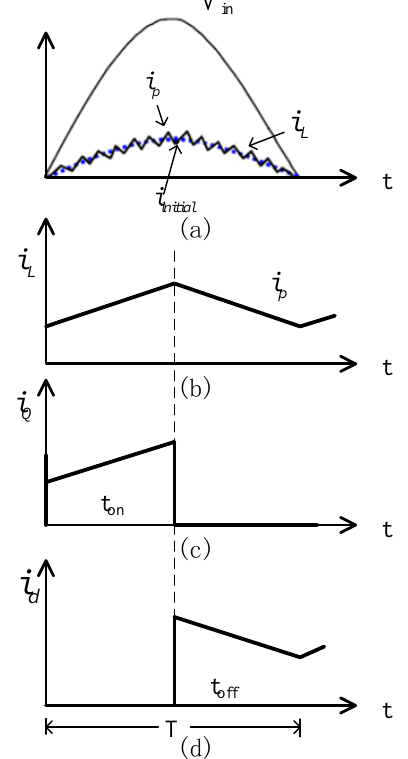
Figure 5. Waveforms of boost converter in continuous mode: ( a ) Voltage and inductor current waveforms; ( b ) Inductor current; ( c ) Switch current; and ( d ) Diode current.